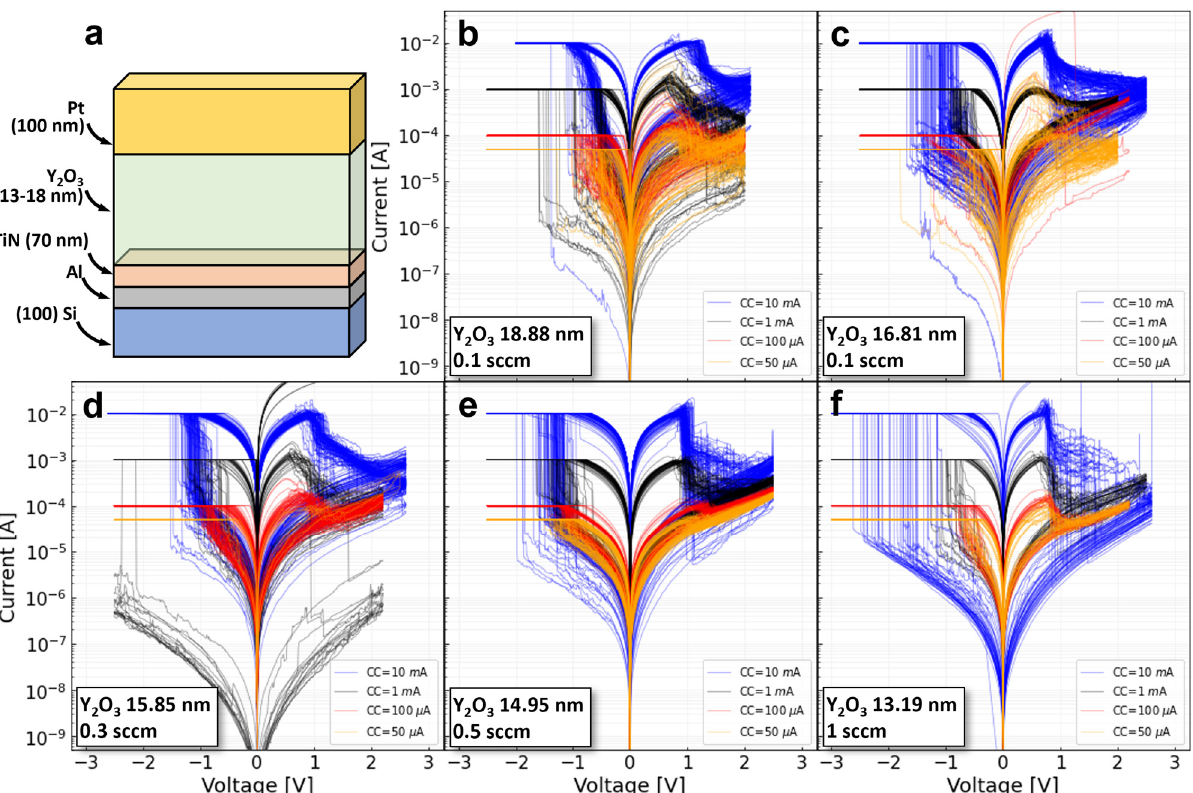
Figure 1. ( a ) Structure of the RRAM devices under test. The insulating layer varies from 13 to 18 nm depending on the oxidation condition. Measured I ‐ V loops from current compliances 50 μ A, 100 μ A, 1 mA, and 10 mA: ( b ) oxygen flow of 0.1 sccm, ( c ) oxygen flow of 0.2 sccm, ( d ) oxygen flow of 0.3 sccm, ( e ) oxygen flow of 0.5 sccm, ( f ) oxygen flow of 1 sccm.